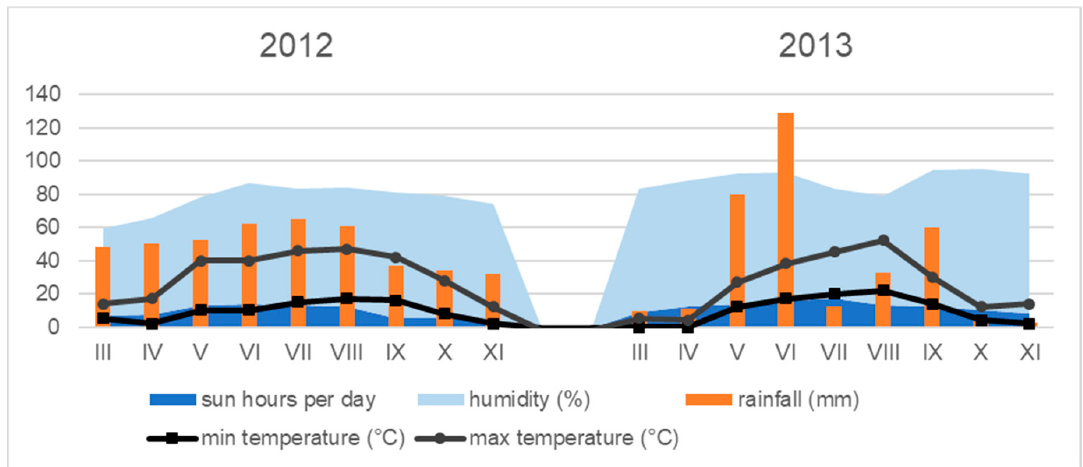
Figure 1. Weather conditions at the experimental station in Skierniewice, Poland, in 2012 and 2013 vegetation seasons.